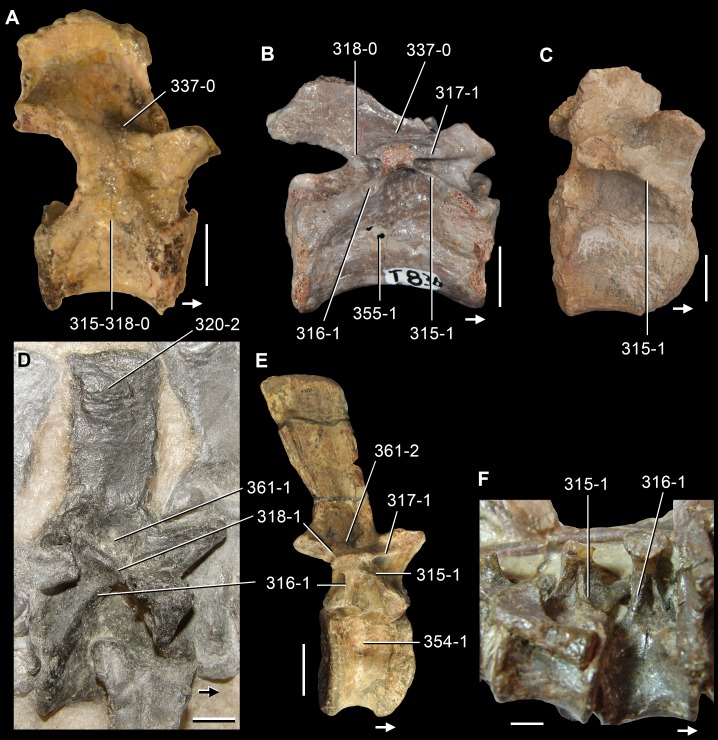
Dorsal vertebrae of Permo-Triassic neodiapsids in (A–E) lateral and (F) ventrolateral views.(A) Anterior-middle dorsal vertebra of Youngina capensis (BP/1/3859); (B) anterior dorsal vertebra of Aenigmastropheus parringtoni (UMZC T836); (C) anterior-middle dorsal vertebra of Tarjadia ruthae (PULR 63, mirrored); (D) first dorsal vertebra of Protorosaurus speneri (BSPG 1995 I 5 [cast of WMsN P47361]); (E) middle dorsal vertebra of Erythrosuchus africanus (NHMUK PV R3592); and (F) middle dorsal vertebrae of Chanaresuchus bonapartei (MCZ 4037). Numbers indicate character-states scored in the data matrix and the arrows indicate anterior direction. Scale bars equal 2 mm in (A), 5 mm in (B, D, F), 1 cm in (C), and 5 cm in (E).